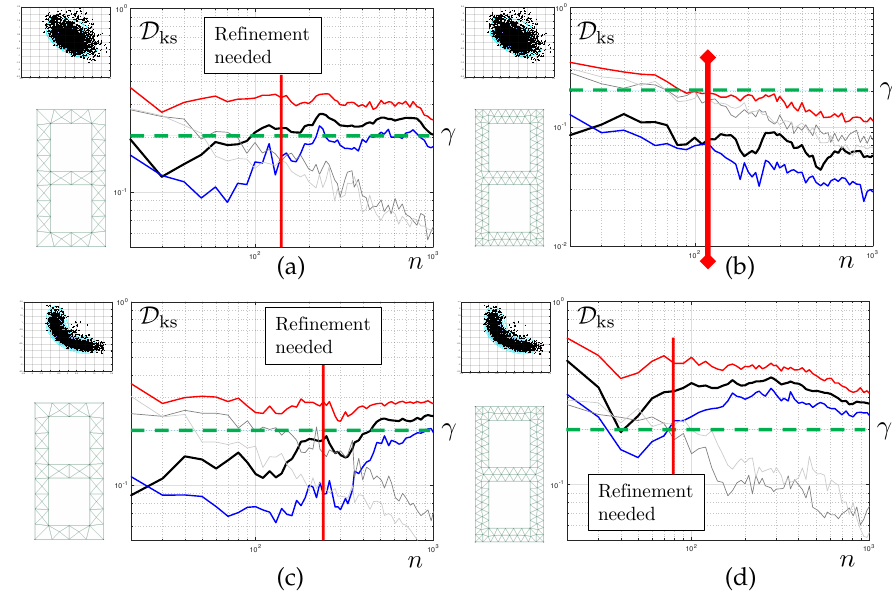
Figure 9. Convergence of the KS distance as a function of the number of Monte-Carlo samples in each chain. The ( a , b ) correspond to the inverse problem where only the first eigenfrequency is observed. ( c , d ) corresponds to the case where the first three eigenfrequencies are observed. The quantity of interest is the fourth eigenvalue, which is unobserved in both cases and must be inferred. The corresponding posterior density is illustrated above the mesh pictogram. Interestingly, the data-poor problem ( a , b ) can be solved appropriately with a coarse mesh, while the data-rich case ( c , d ) requires a much finer grid to be solved